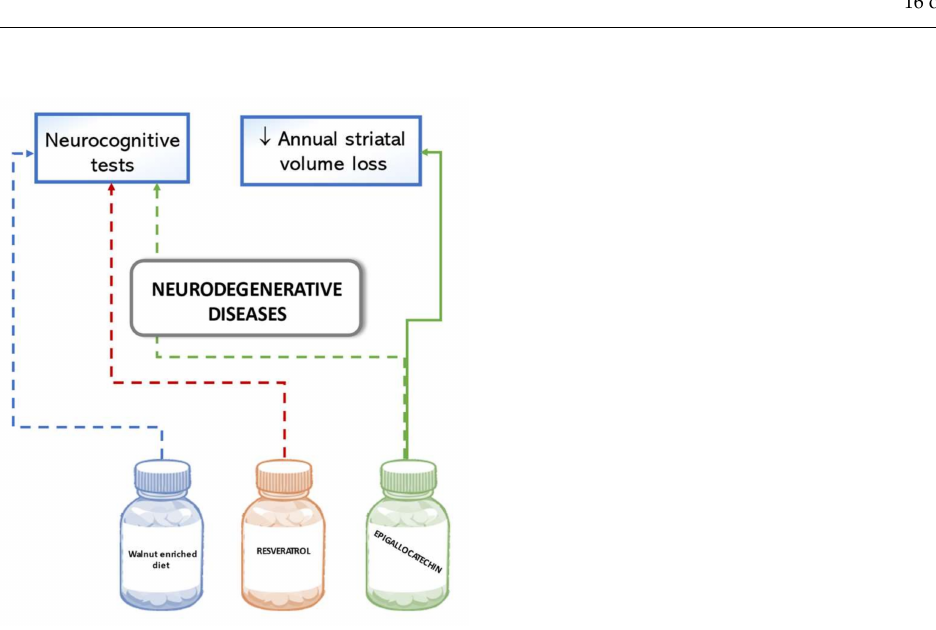
Figure 7. Effects of polyphenols on neurodegenerative diseases in human studies. Dashed lines indicate a lack of significant